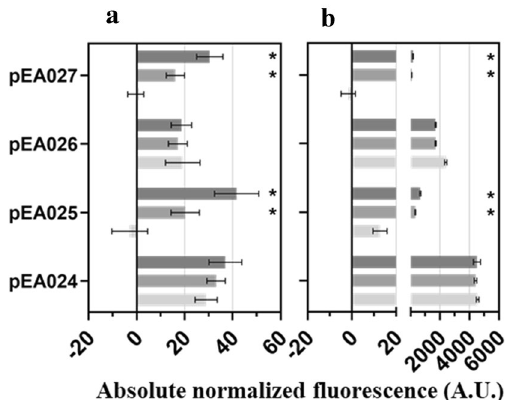
Figure 6. Inducible systems Pf PdhR/P lldP and Pl PdhR/P lldP from P. fluorescens NCTC 10,038 and P. lactis DSM 29,167, respectively, mediate controllable gene expression in C. necator H16 and P. putida KT2440. Single time- point fluorescence measurements of ( a ) C. necator H16 and ( b ) P. putida KT2440 carrying the plasmids pEA024 and pEA026 containing ‘promoter only’ ( Pf PdhR/P lldP and Pl PdhR/P lldP , respectively), and plasmids pEA025 and pEA027 containing TR gene and promoter ( Pf PdhR/P lldP and Pl PdhR/P lldP , respectively). RFP fluorescence output was determined in the absence of inducer (light grey) and 12 h after extracellular supplementation with L-lactate (middle grey) and D-lactate (dark grey) to a final concentration of 5 mM. Cells were grown in minimal medium containing 0.4% glucose (in the case of C. necator H16 supplemented with 0.4% gluconate). Error bars represent standard deviations of three biological replicates, * p ≤ 0.01 (unpaired t